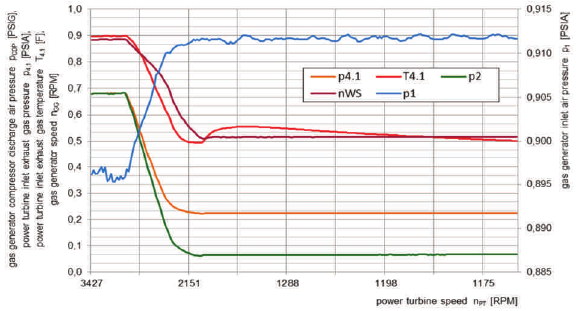
Fig. 17. Changes of LM 2500 engine operating parameters depending on the power turbine speed n PT during